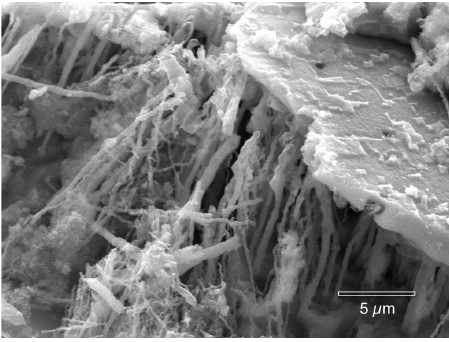
Figure 10. Microbial filaments deep inside a corrosion pit (HMDS fixation).